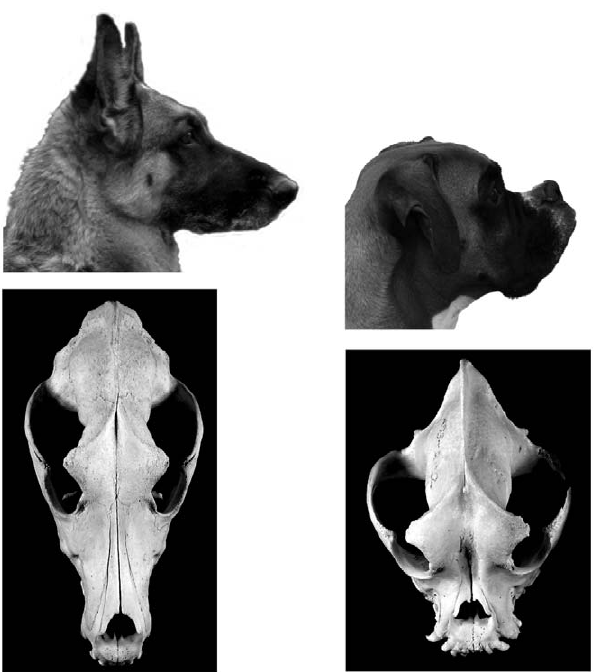
Figure 1. Brachycephaly in dogs. Comparison of photographs (Photos Mary Bloom, courtesy of AKC) and skulls from a German Shepherd Dog with a wild-type skull shape (non-brachycephalic) and a brachycephalic Boxer.